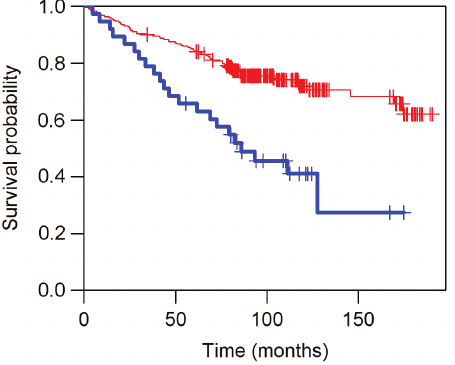
Figure 1: Kaplan-Meier survival curves of 288 patients investi- gated before the start of therapy with urinary neopterin ≥ (full line) and < (thin line) 238 μ mol/mol creatinine (p <